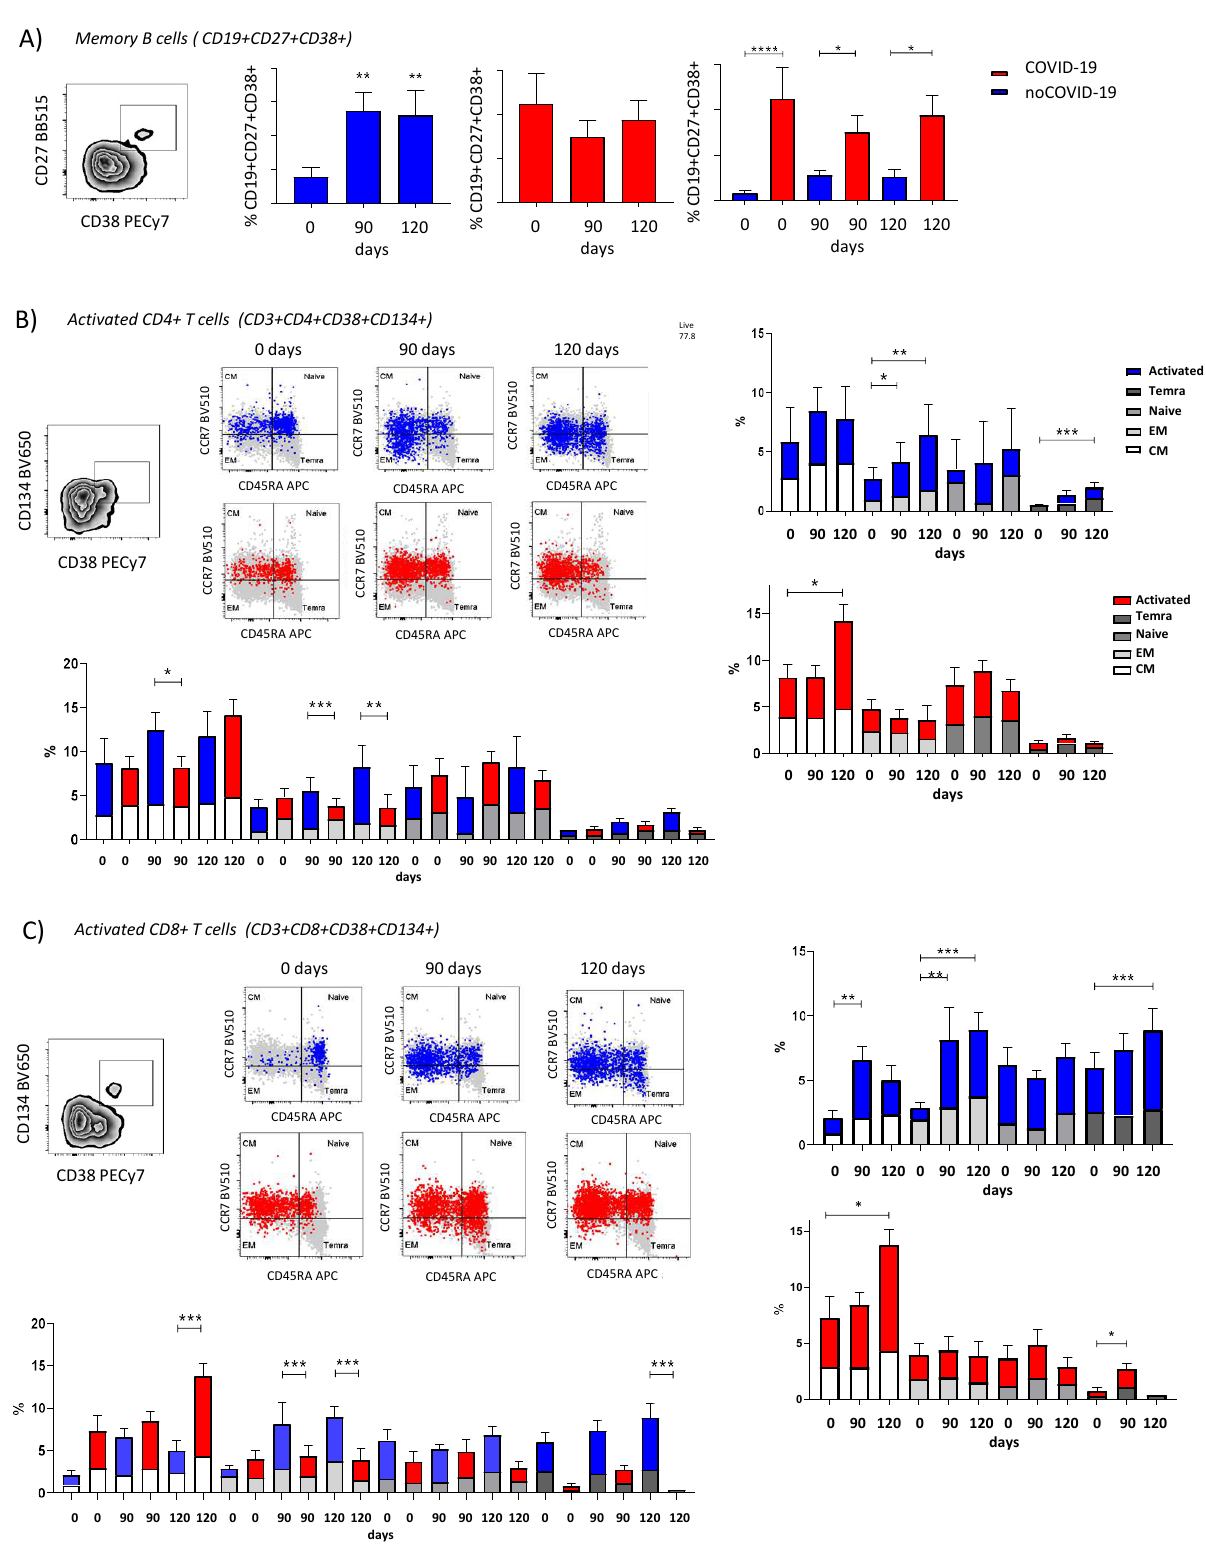
Figure 6. Immunophenotyping of memory B and T lymphocytes after ChAdOx1 nCoV-19 vaccination. The activated cells for the COVID-19 group are in red, and the activated cells for the no-COVID group are in blue for the B and T cell phenotypes. The profiles of ( A ) memory B cells (CD19+ CD27+ CD38+), ( B ) activated memory CD4+ T cells (CD3+ CD4+ CD38+ CD134+), (and ( C ) CD8+ T cells (CD3+ CD8+ CD38+ CD134+) and subpopulations of terminally differentiated effectors (Temra)